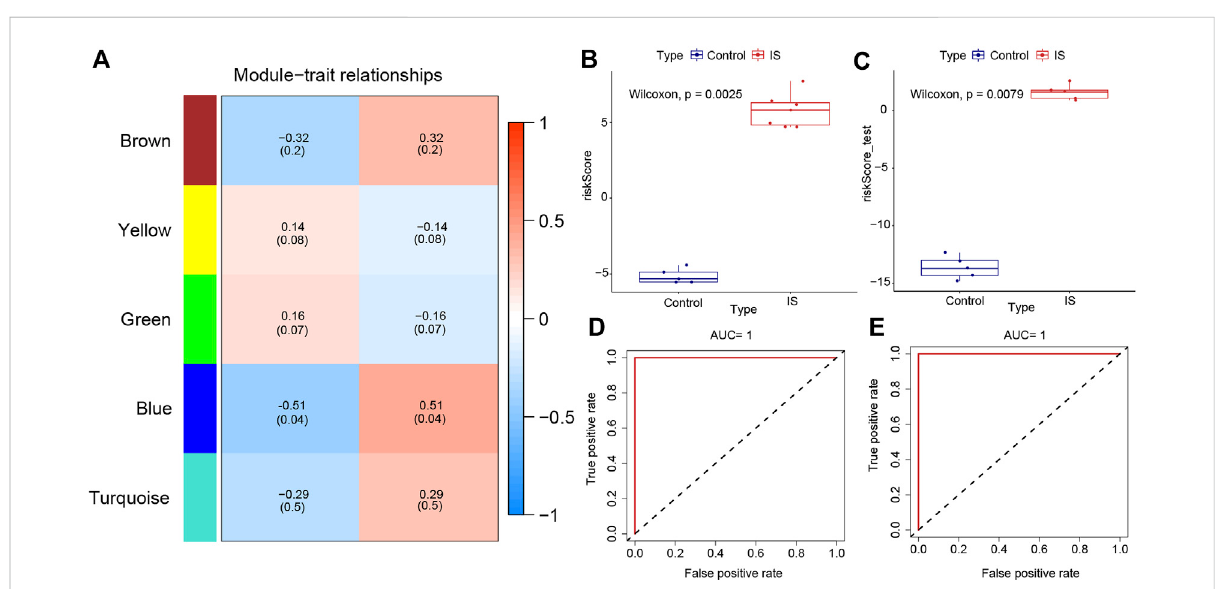
FIGURE 5 Weighted gene co-expression network analysis and the construction of diagnostic model. (A) Heat map of correlations between modules and samples. (B) Differencesin model scores betweenischemicstroke (IS)and control groups in training set. (C) Differencesin model scores between IS and control groups in the testing set. (D) Corresponding receiver operating characteristic (ROC) curves and area under the curve (AUC) values in the training set. (E) Corresponding ROC curves and AUC values in testing